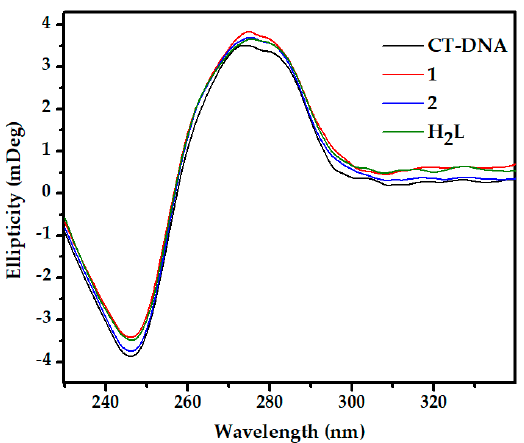
Figure 5. Circular dichroism spectra of CT–DNA (150 µ M) in the presence and absence H 2 L, and